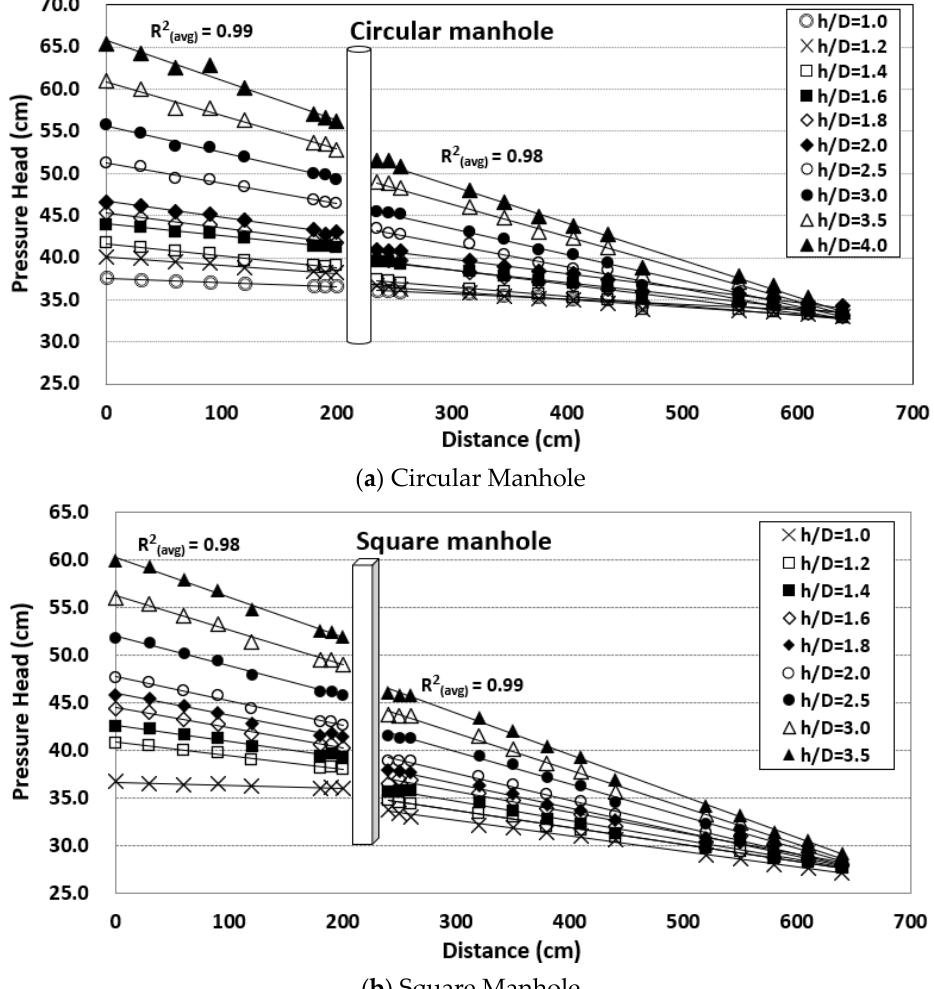
Figure 4. Change of head loss at surcharge manhole with variation of inlet discharge.